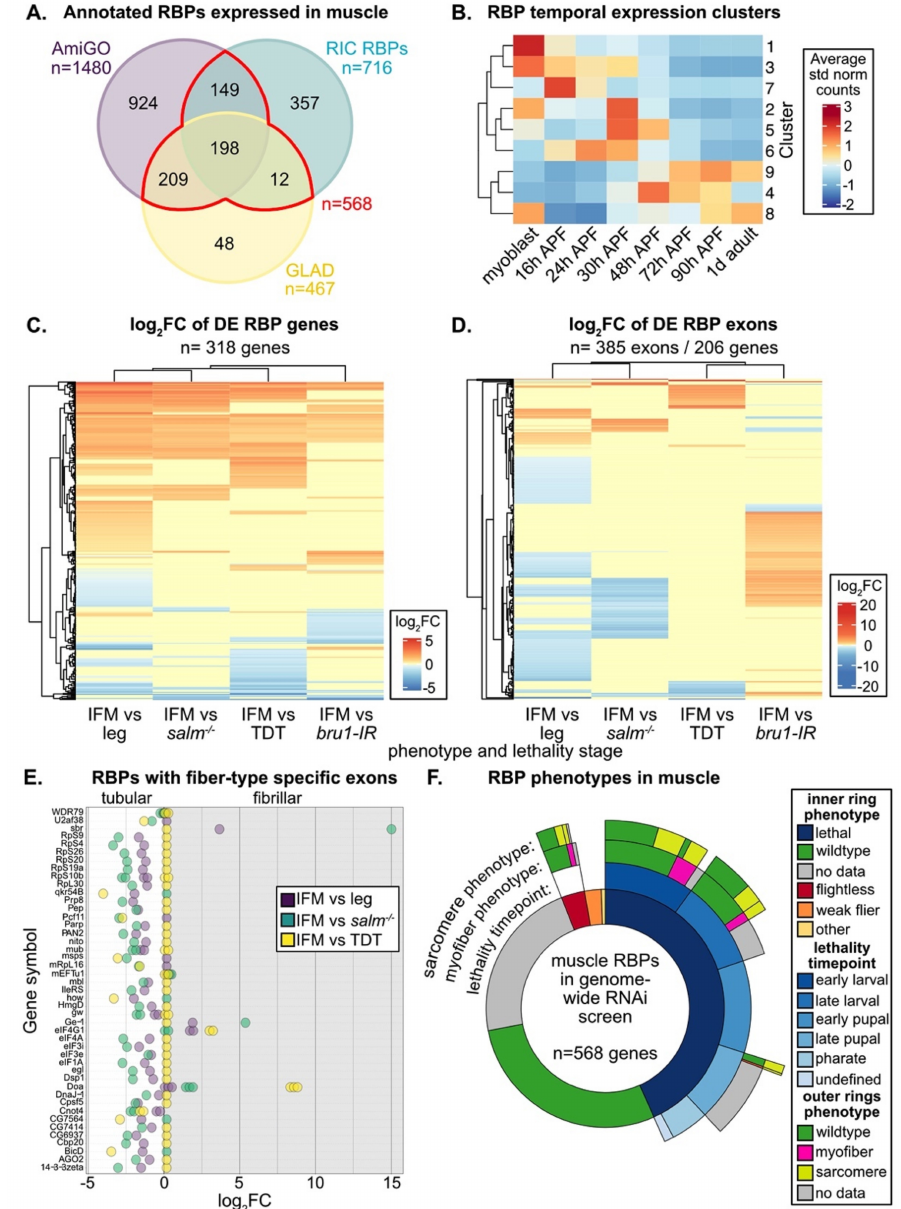
Figure 1. RNA binding proteins (RBPs) have fiber-type and temporal dependent expression patterns in muscle. ( A ) Comparison of RBPs from AmiGO (purple), GLAD (yellow) or RNA-interactome capture (RIC, cyan) annotations that